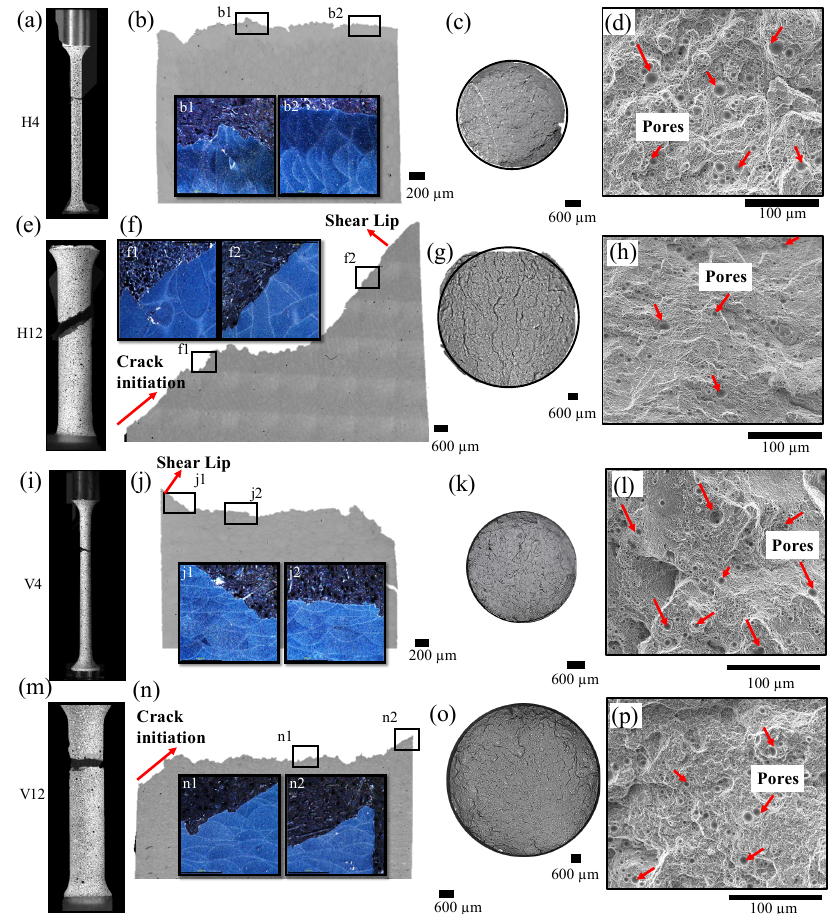
Figure 7. Overview of the fractography investigation conducted on the horizontally built tensile specimens with a diameter of ( a – d ) 4 mm and ( e – h ) 12 mm. ( a , e ) Location of failure in the tested tensile samples; ( b , f ) bright-field OM images of the specimens’ cross-section perpendicular to the failure plane with dark-field OM insets showing the arrangement of the scan tracks/melt pools along the fracture surface boundary; ( c , g ) OM and ( d , h ) SEM micrographs of the corresponding fracture surfaces. Overview of the fractography investigation conducted on the vertically built tensile specimens with a diameter of ( i – l ) 4 mm and ( m – p ) 12 mm.